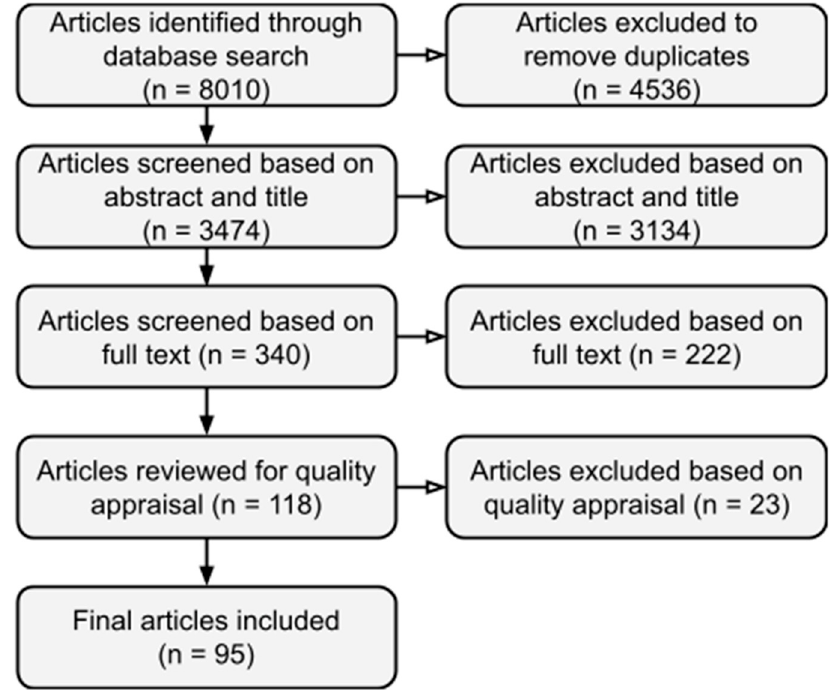
Figure 1. Database search strategy.